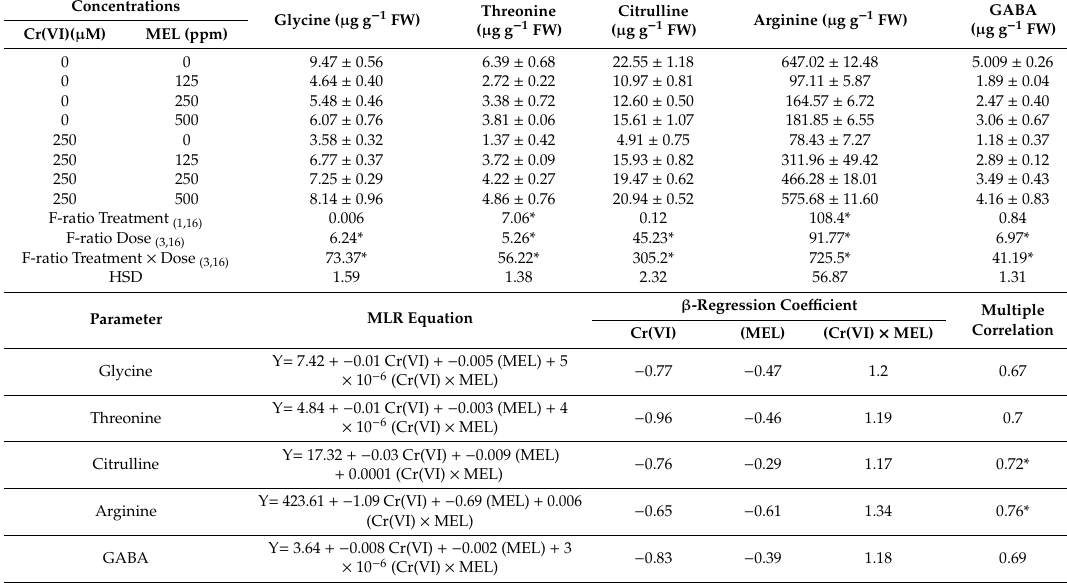
Table 10. E ff ect of Cr(VI), di ff erent concentrations of methanol extract of Rhododendron arboreum leaves (MEL), and their combinations on glycine, threonine, citrulline, arginine, and gamma-aminobutyric acid (GABA) contents in 7-day-old Vigna radiata seedlings. The values are the means of three replicates ± SD. (standard deviation). Tukeys test performed and significance checked at * p ≤ 0.05. The F ratio is the term in which ANOVA is represented; Cr(VI) = Dose, MEL treatments = Treatment and combination of Cr(VI) and MEL = Dose ×